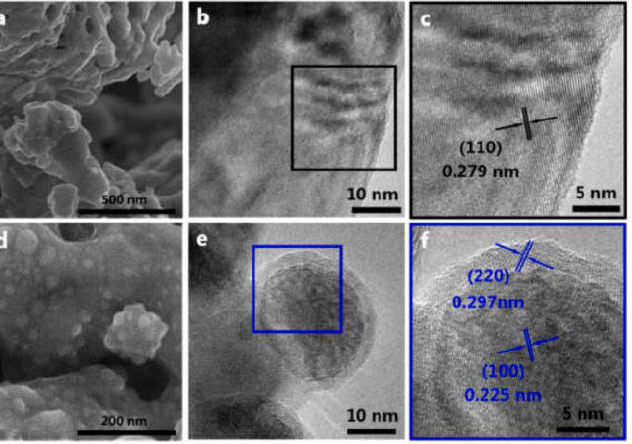
Figure 22. ( a ) SEM and ( b , c ) TEM images of as-prepared PSFRN. ( d ) SEM and ( e , f ) TEM images of R-PSFRN (adapted from ref.